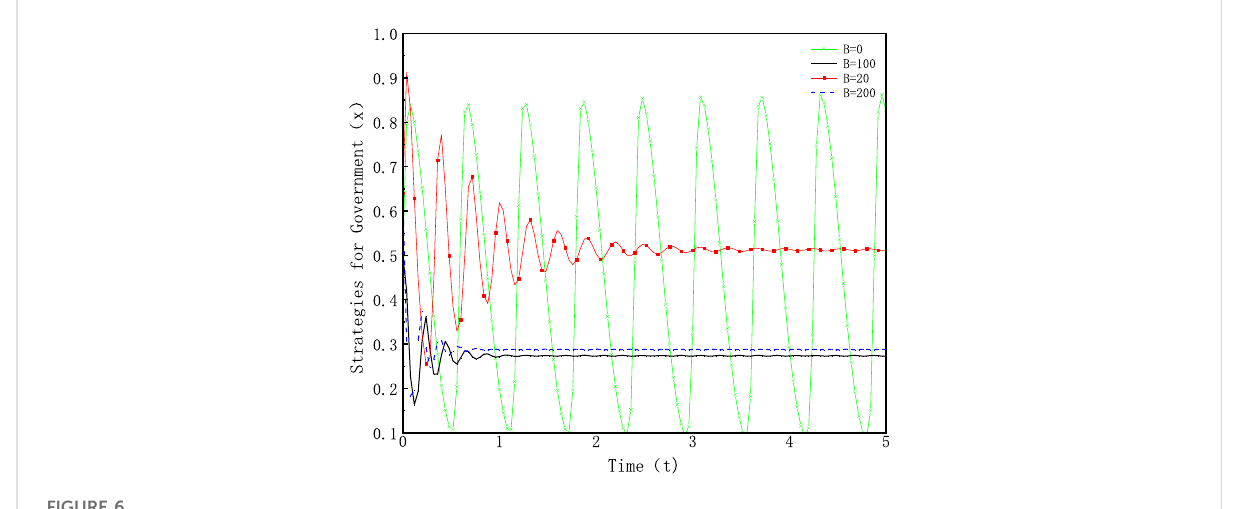
FIGURE 6 Strategies evolution of government under different